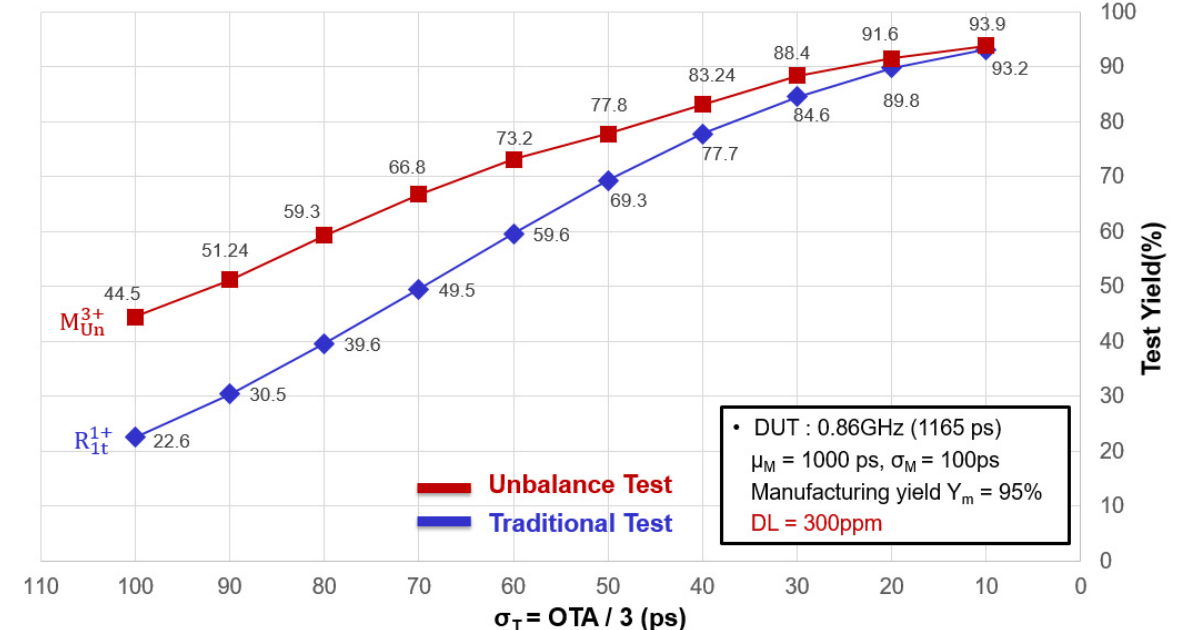
Figure 5. Proposed decision diagram for unbalanced testing ( M (cid:2905)(cid:2924)(cid:2871)(cid:2878) ). Figure 5. The impact of test parameter OTA on test Table 3. Unbalance testing methods enhance the testing capabilities of the tester.